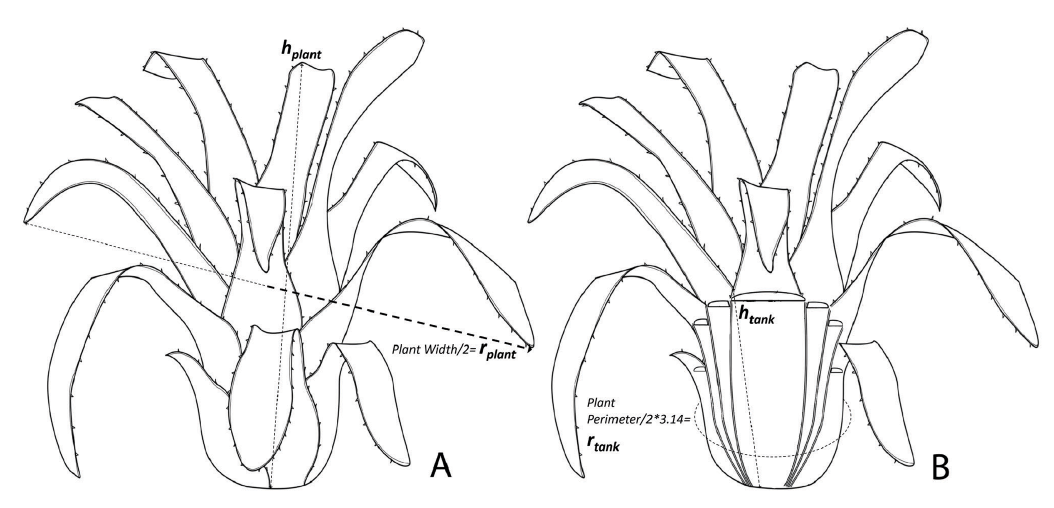
Figure 2. Morphometric parameters measured in the plants (A) and bromeliad tank (B). Dashed lines represent plant measures used in our